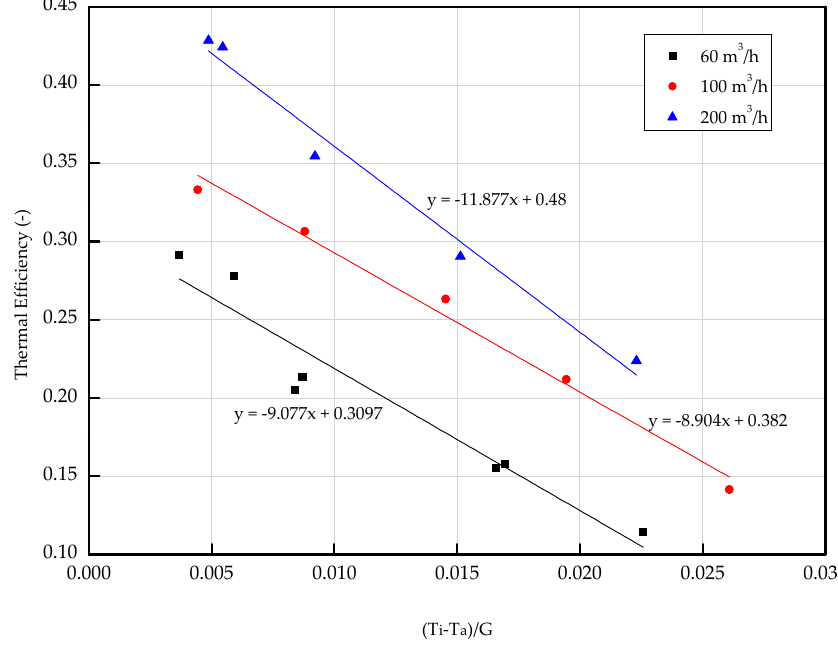
Figure 4. Thermal efficiency for different air flow rates.